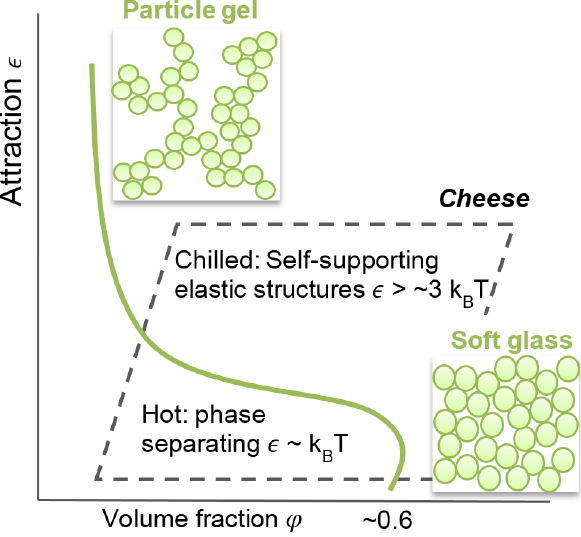
Figure 1: Phase diagram of hard particles, and the proposed posi- tioning of cheese, adapted from Trappe and Sandkuhler